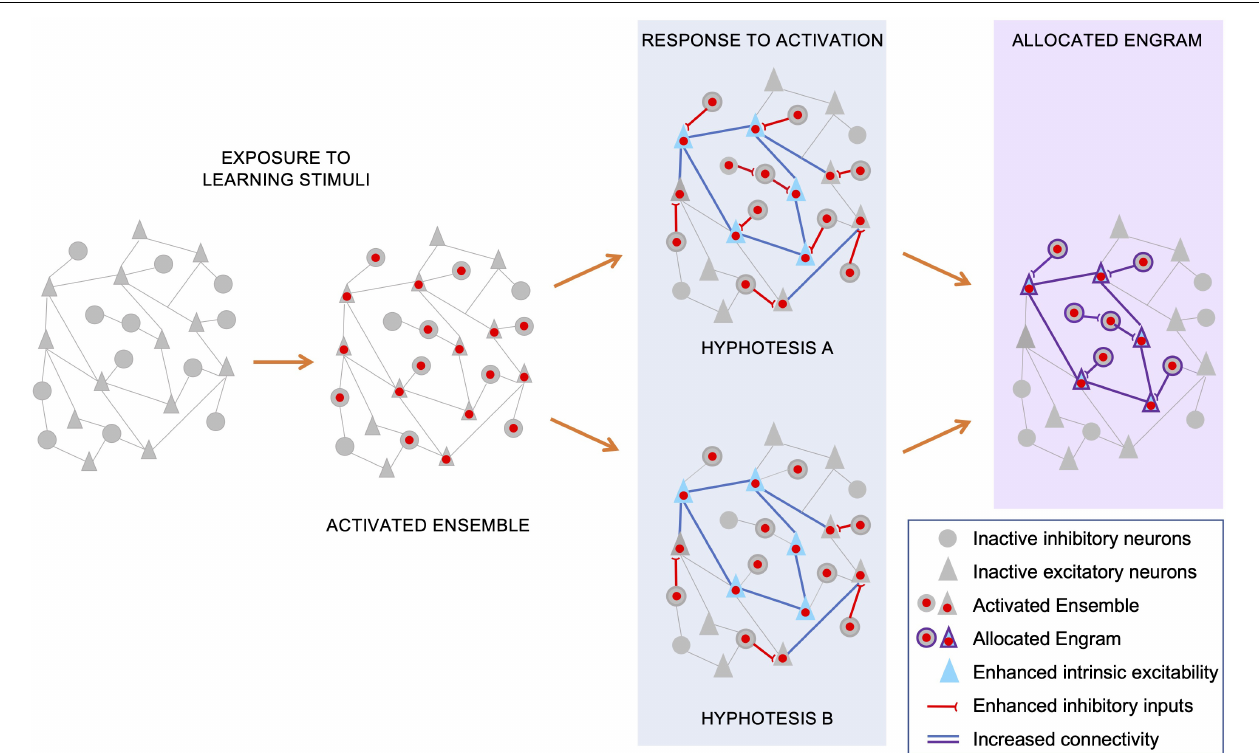
FIGURE 2 | Potential mechanisms underlying allocation of the inhibitory and excitatory components of the engram. During memory acquisition (“exposure to learning stimuli”), an initial ensemble of inhibitory and excitatory neurons are activated, and their nuclei (red dots) undergo activity-dependent IEG/LRG transcription. The consequent expression of activity-dependent genes, combined with synaptic plasticity changes triggered by neuronal activation, leads to circuit-wide rearrangements of neuronal connectivity. For a subset of pyramidal neurons, these rearrangements include both enhanced intrinsic excitability (blue triangles) and increased synaptic strength among their synapses (blue lines). Concomitantly, activation of both inhibitory and excitatory neurons elicits an enhancement in strength and number of inhibitory inputs onto activated pyramidal neurons. Independent reports suggest that both heightened inhibition onto excitatory neurons and their increased intrinsic excitability contribute to restrict engram allocation. Regarding a potential underlying mechanism, we suggest two, non-exhaustive, scenarios. In a first scenario (hypothesis A), increased inhibitory inputs could be induced onto most, if not all, activated pyramidal neurons. Consequently, only those neurons with an intrinsic excitability able to override this increased inhibitory drive can win the competition for engram allocation. In this scenario, those inhibitory neurons targeting successfully allocated engram cells could become the inhibitory component of that engram, controlling its storage and recall. In an alternative hypothesis (hypothesis B), heightened inhibition and increased intrinsic excitability do not co-exist, targeting distinct subsets of activated pyramidal neurons. Those ensemble pyramidal neurons that receive increased inhibitory inputs would be excluded from allocation, while those with an increased intrinsic excitability would be more likely selected as engram neurons. In this model, those GABAergic neurons initially recruited to restrict the allocation process, would most likely be excluded from the consolidated engram ensemble. Hence, the inhibitory component of the allocated engram may be recruited in a subsequent phase, possibly as a homeostatic response to the increased excitation of engram pyramidal